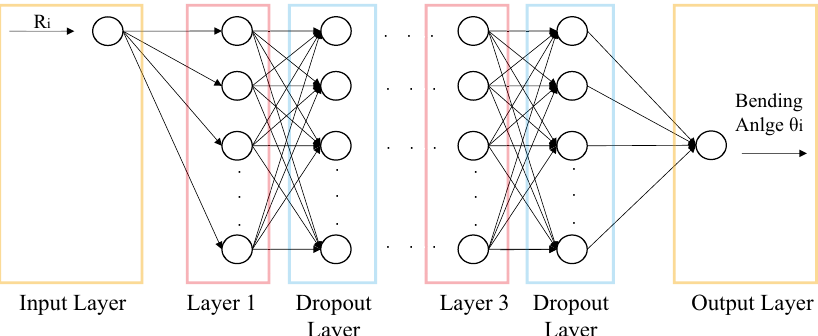
Figure 5. Structure of the calibration neural network based on a long short-term memory (LSTM) neural network. One input layer, three hidden layers with dropout layers and one output layer are